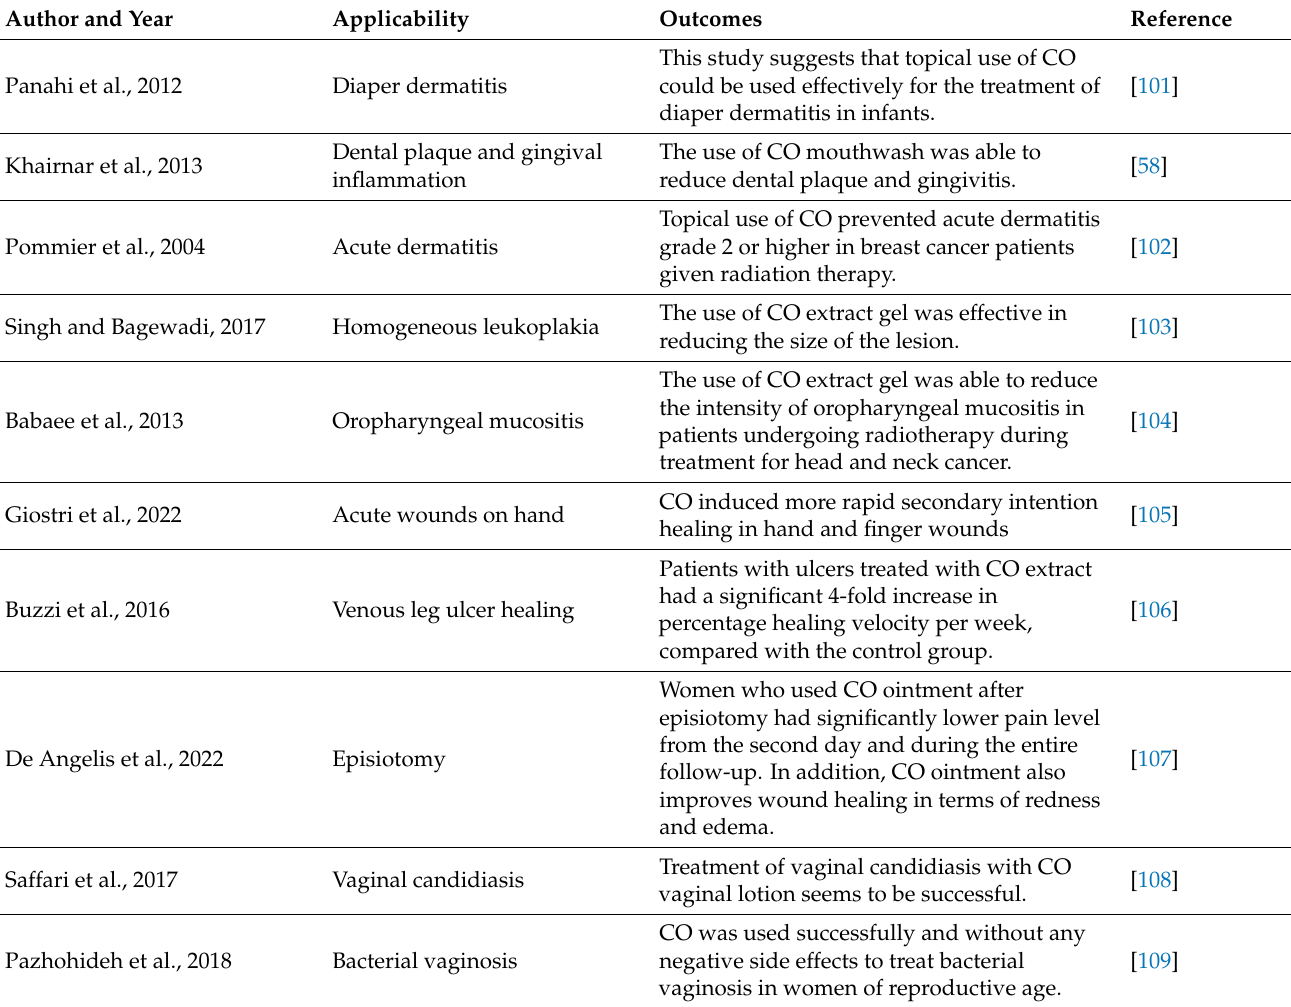
Table 3. Summary of clinical studies of the use of Calendula officinalis